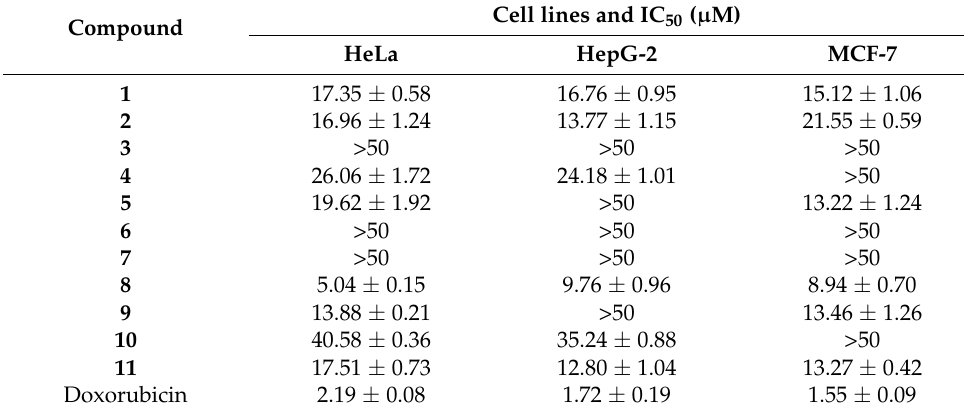
Table 3. Cytotoxic activities of compounds 1 – 11 against three cancer cell